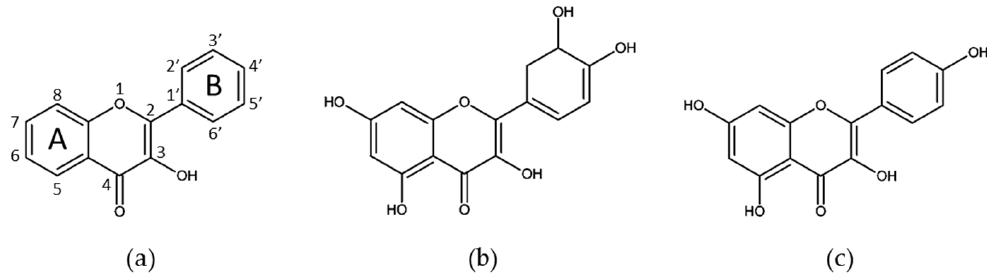
Figure 2. ( a ) Basic structure of flavonols. ( b ) Kaempferol. ( c ) Quercetin.